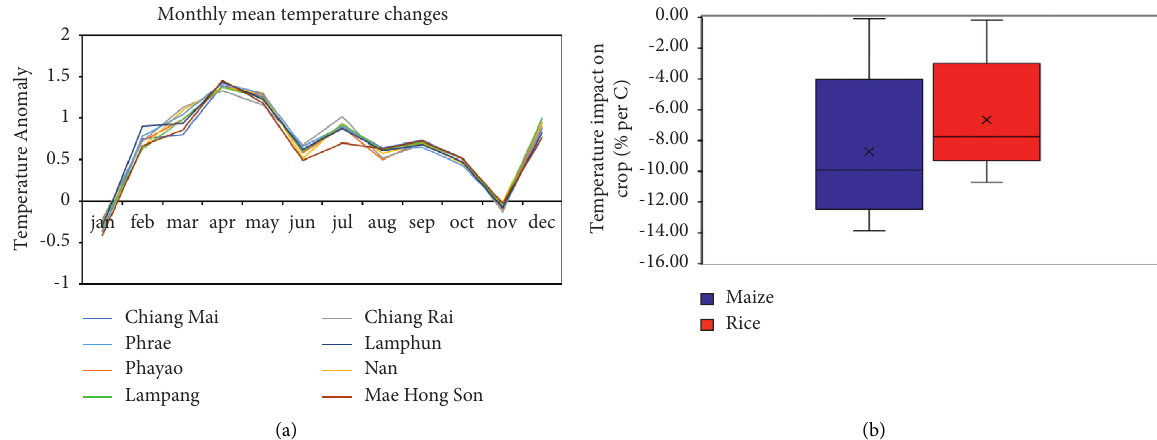
Figure 6: (a) Monthly mean temperature change in 2020–2029 compared to 1990–1999, (b) averaged rice and maize change during planting season in 2020–2029 compared to